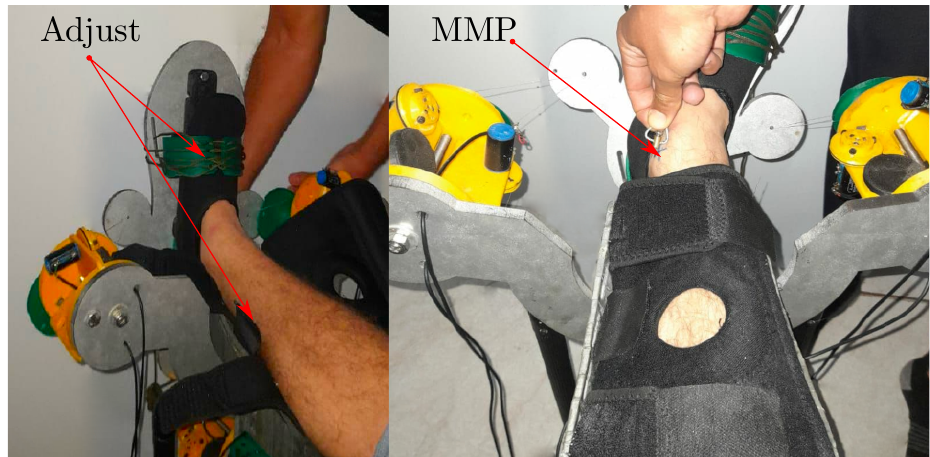
Figure 13. Adjusting the foot, the shank and the Most Medial Point